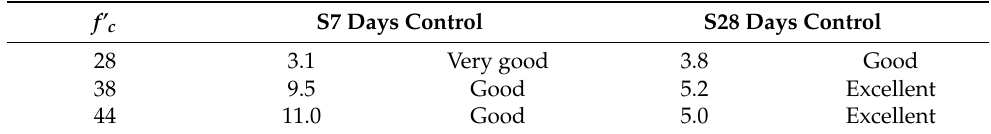
Table 3. Batch-to-batch control classification 1 .